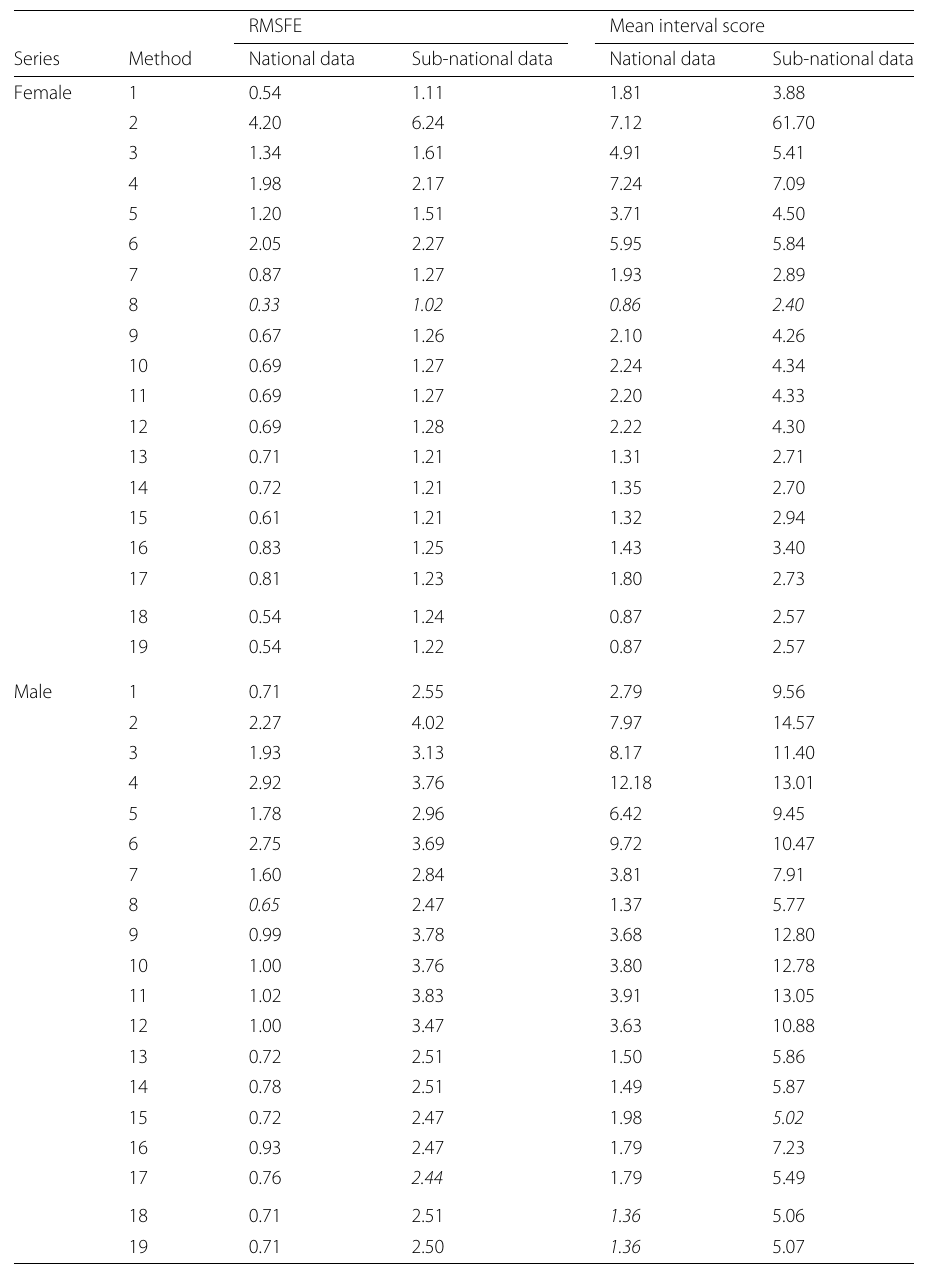
Table 6 Point and interval forecast accuracies among the 17 models and two model-averaged methods in the Japanese national data and the average of 47 sub-national populations for ages between 60 and 100+